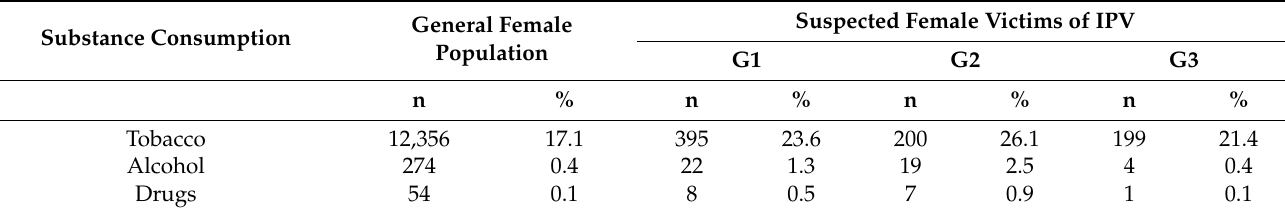
Table 2. Victims’ history of substance consumption (health risk behaviours).